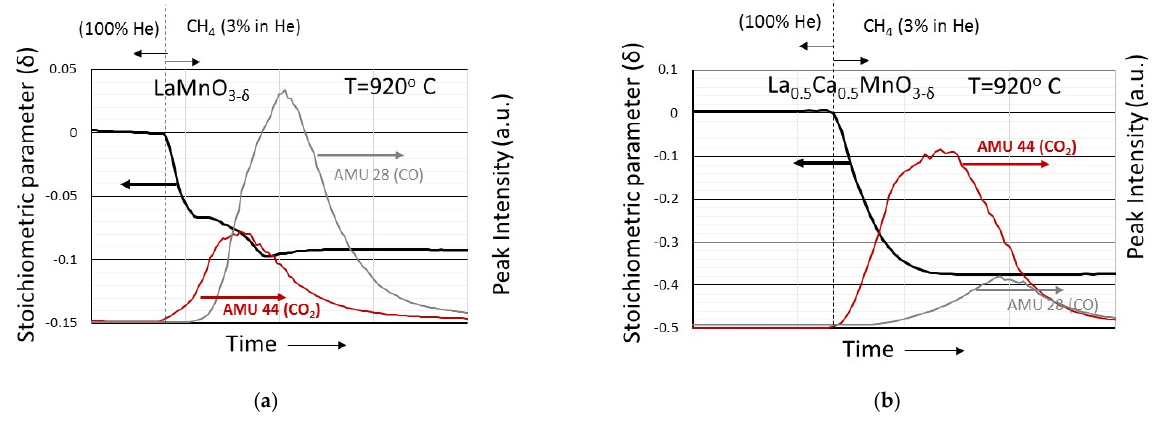
Figure 10. Evolution of CO and CO 2 characteristic mass spectrometer peaks (at Atomic Mass Units 28 and 44, respectively) that accompany the weight loss curves of ( a ) LaMnO 3- δ and ( b ) La 0.5 Ca 0.5 MnO 3- δ upon reduction with 3% CH 4 (in He) at 920 °C.